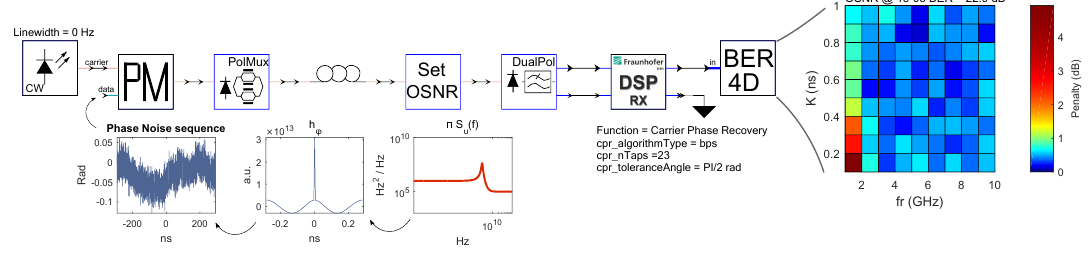
Figure 4. Simulation setup for a semiconductor laser.